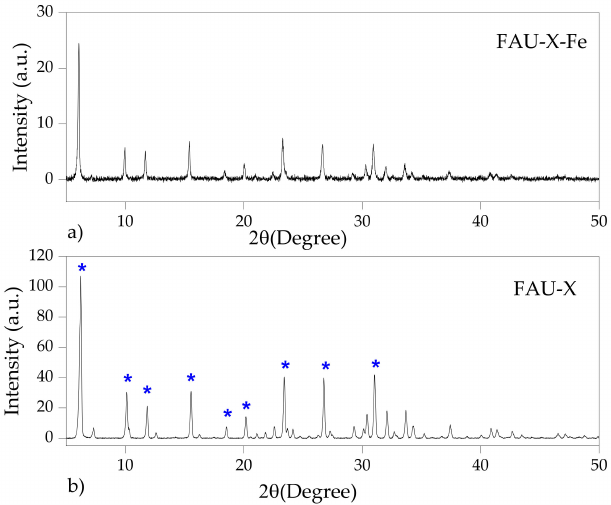
Figure 4. XRD of the FAU-X zeolite: ( a ) parent form FAU-X and ( b ) iron form